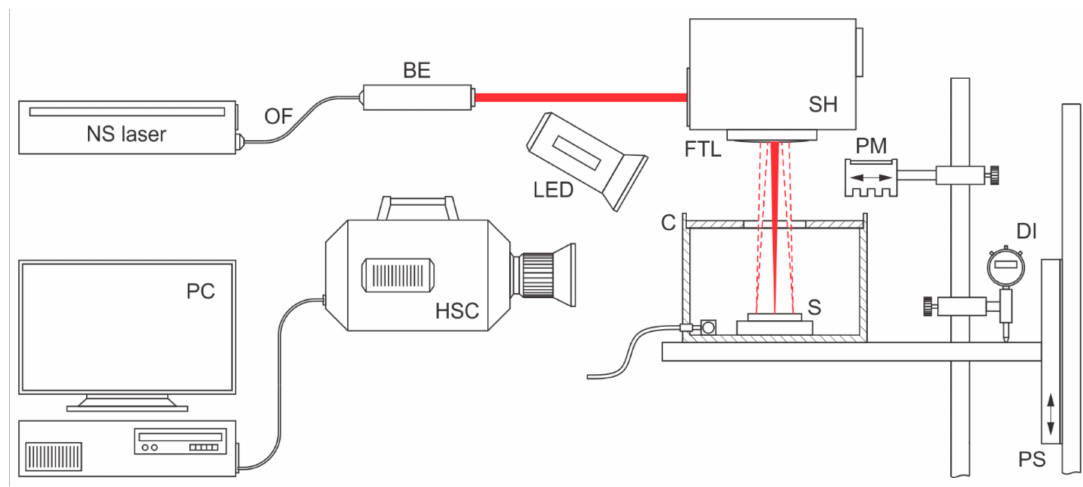
Figure 1. Experimental